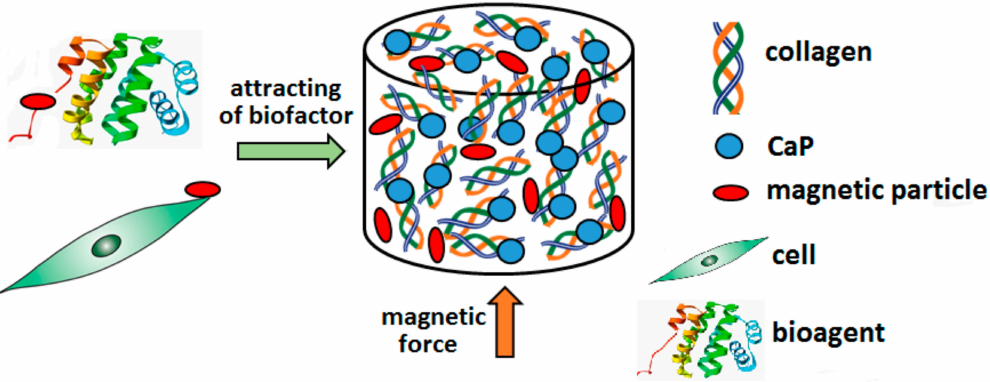
Figure 8. Schematic illustration of magnetic COL / CaP sca ff old according to Bock et al.